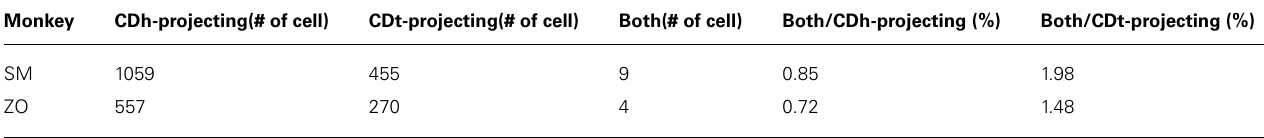
Numbers indicate CDh-, CDt-, and both projecting neurons. Percentage indicates the proportion of both projecting neurons within CDh-projecting or CDt-projecting neurons.